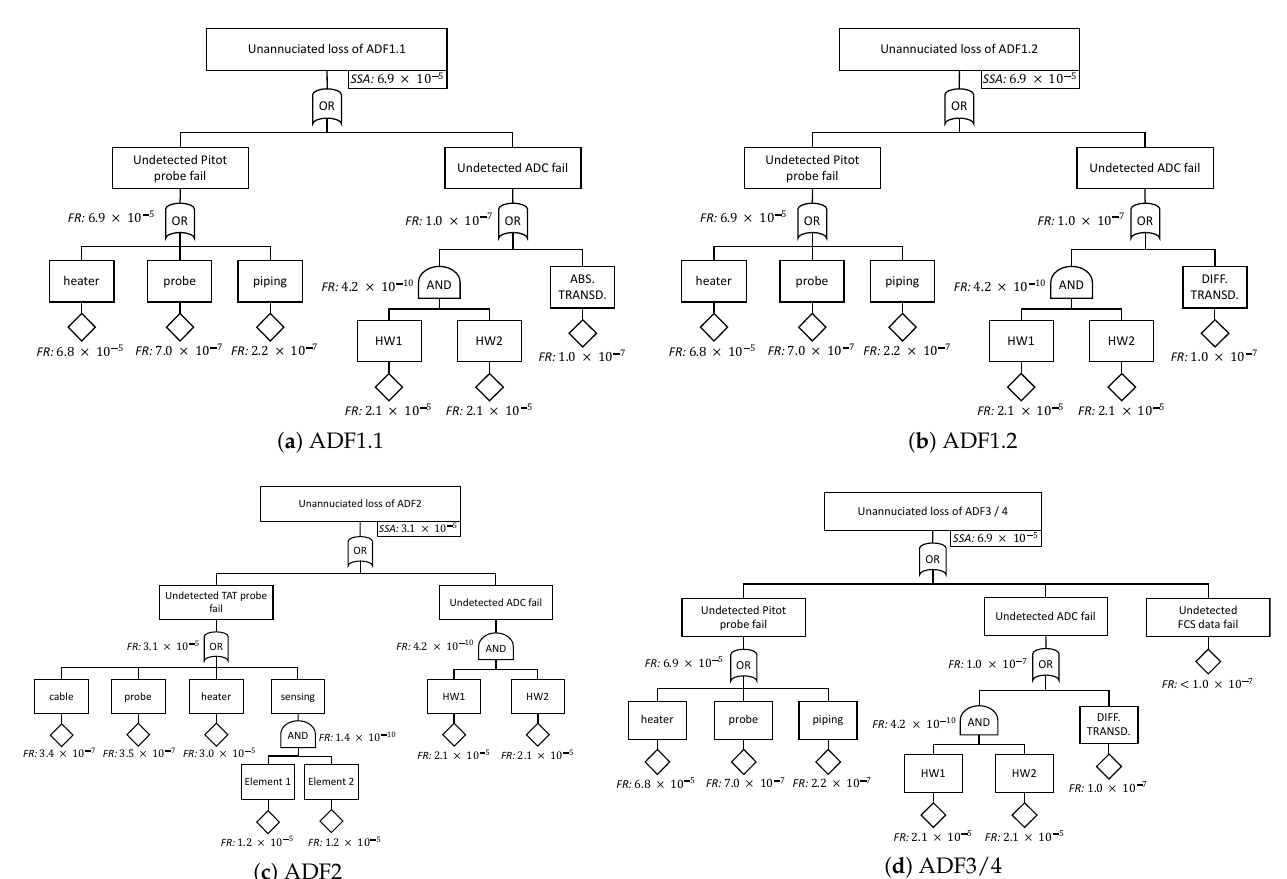
Figure 5. System safety assessment for air data